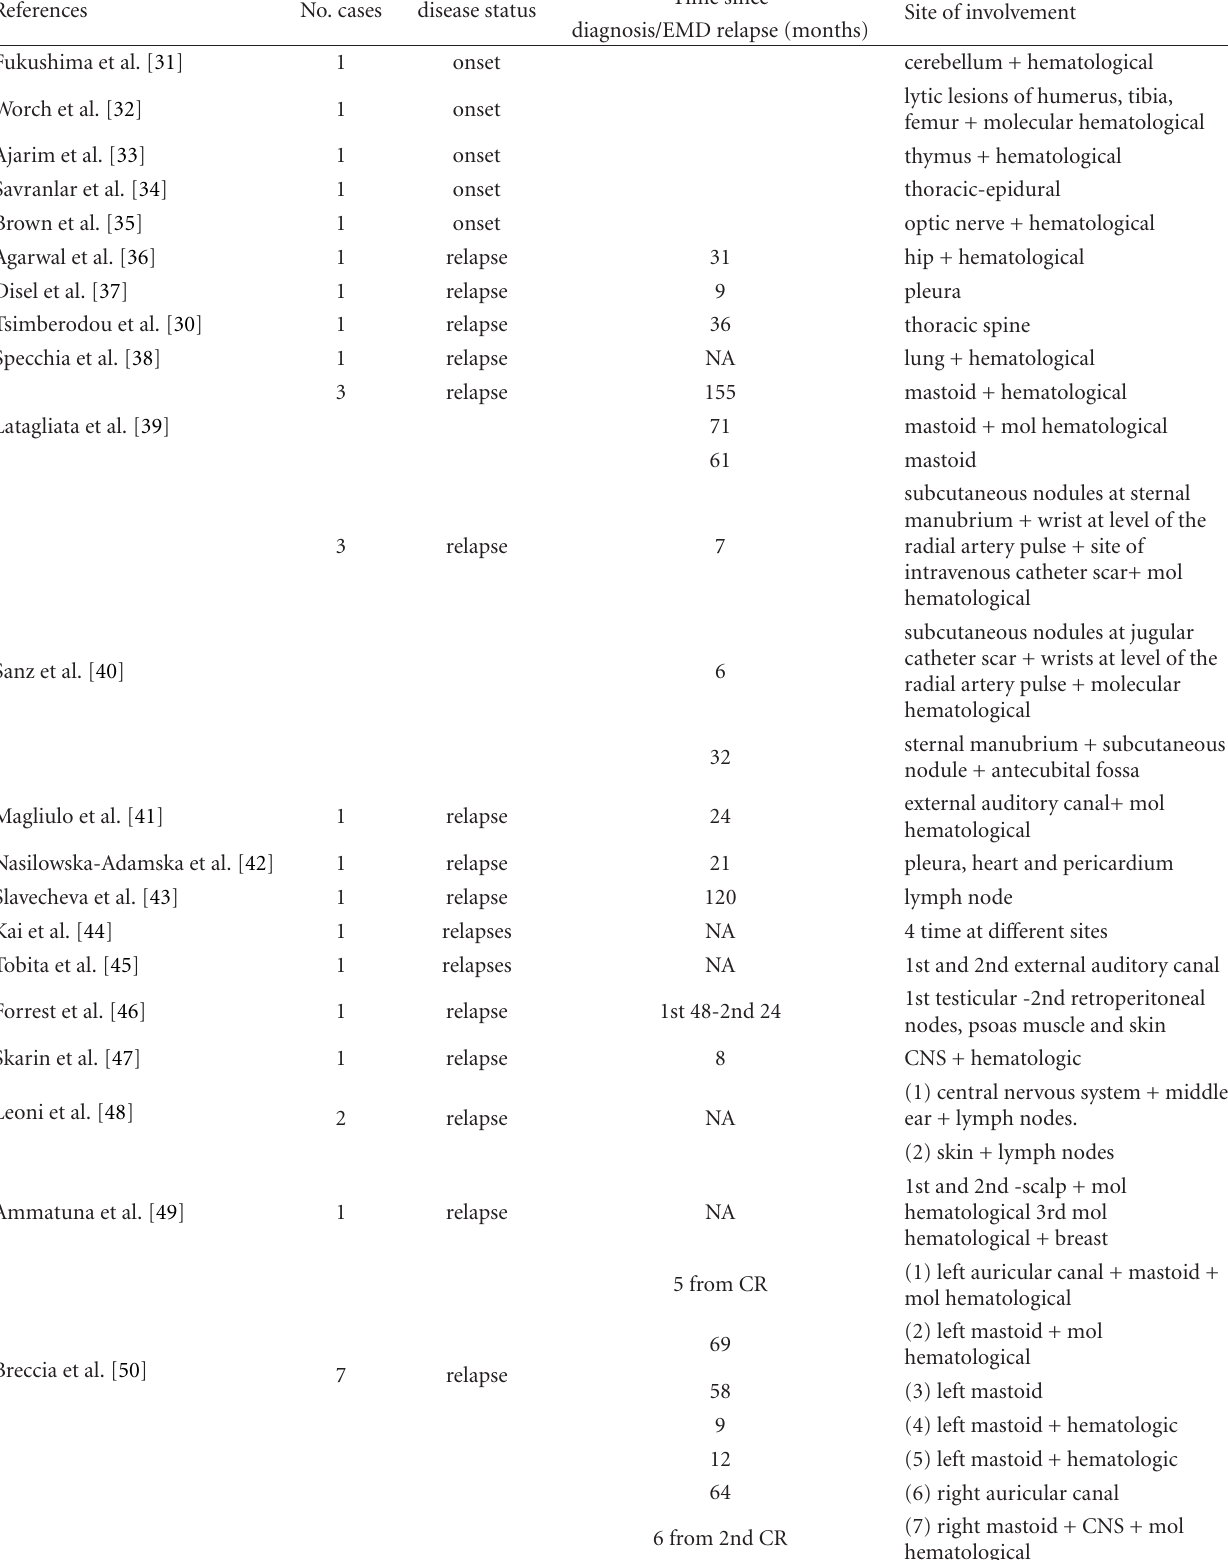
Table 1: Clinical features of patients with MS in